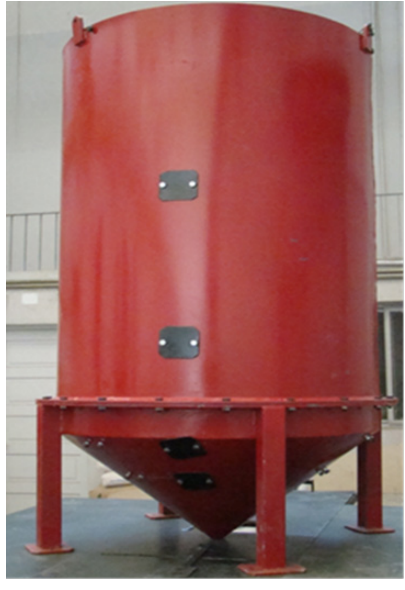
Figure 1: The used model in the experiments.